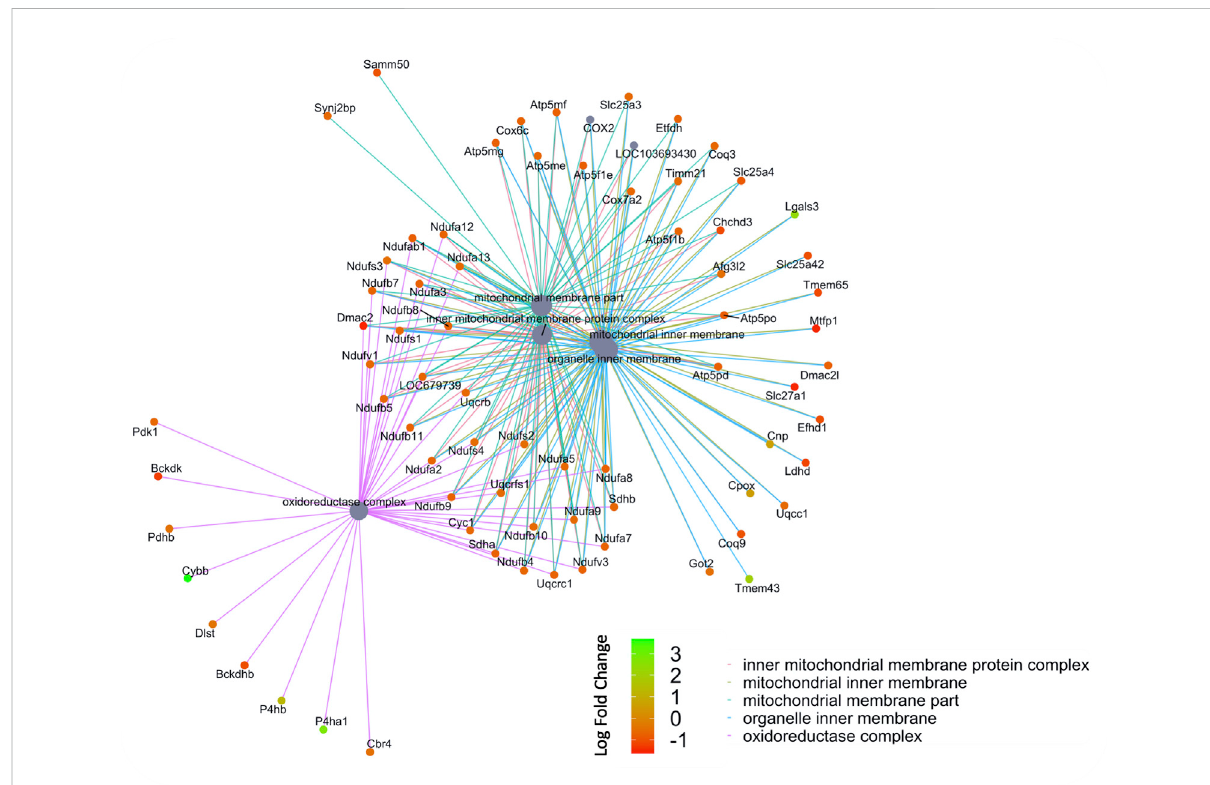
FIGURE 5 Network of GO enriched terms within the Cellular Component Domain. An enrichment of terms describing “ mitochondria ” was resolved when we performed functional analysis on the 410 proteins that are also differentially regulated at the transcript